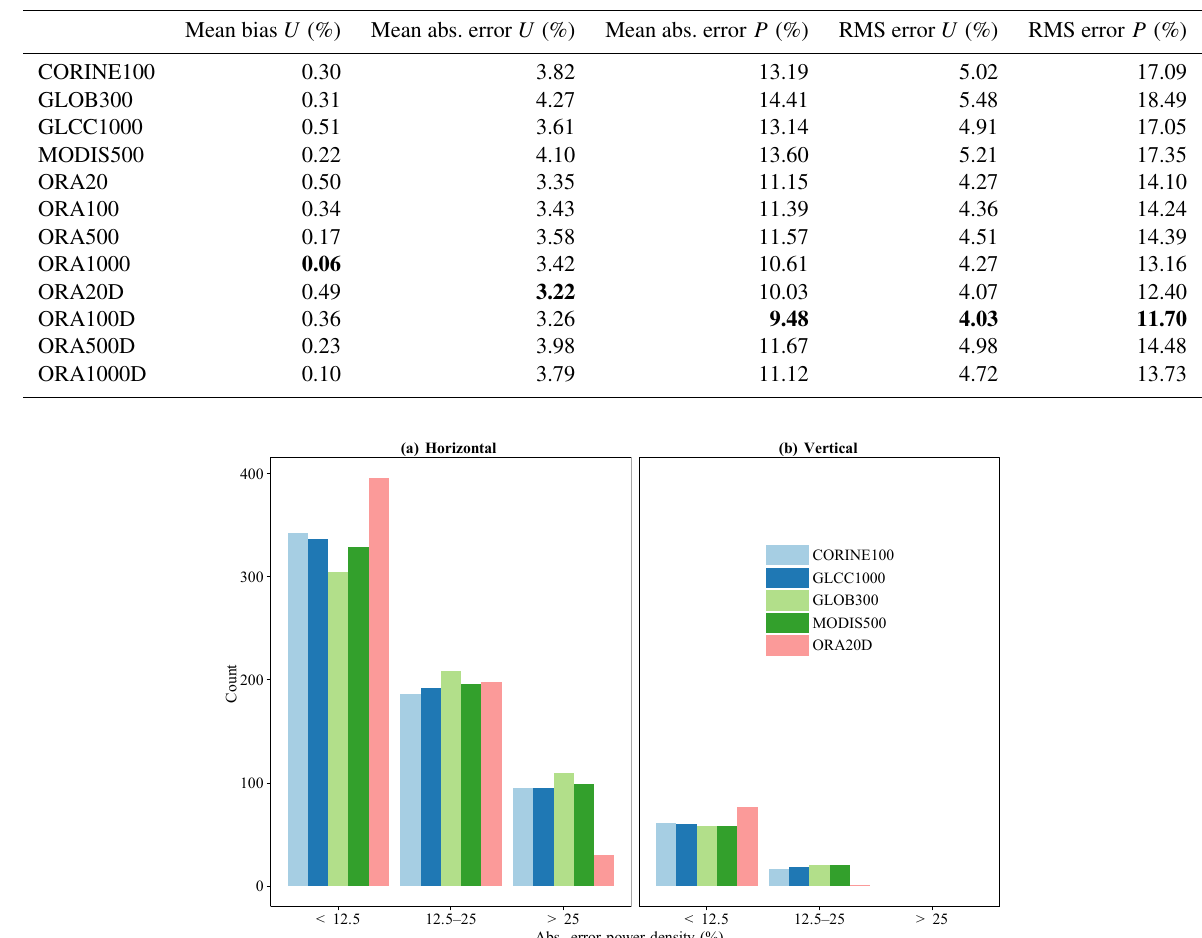
Figure 10. Absolute percent errors of the power density for 702 cross predictions using simulations with different